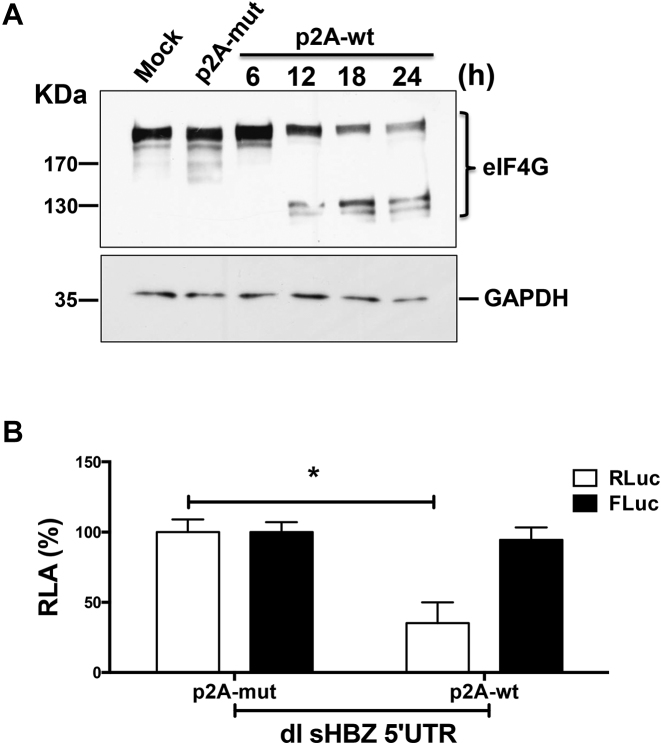
Translation promoted by the sHBZ 5′UTR is resistant to the proteolytic cleavage of eIF4G by the HRV 2A protease. (A) COS-7 cells were transfected with plasmids expressing the wt (p2A-wt) or mutant (p2A-mut) HRV 2A protease. Total protein was harvested from cells transfected with p2A-wt at 6, 12, 18 and 24 h post-transfection. Protein lysates from cells transfected with the empty vector (Mock) or with the p2A-mut plasmid were harvested 24 h post-transfection. Western analysis was performed using a polyclonal antibody against eIF4GI. The positions of the molecular mass standards (in kDa) are shown. (B) COS-7 cells were transfected with plasmids p2A-wt or p2A-mut together with the dl HBZ 5′UTR plasmid and 24 h post-transfection. RLuc and FLuc activities were measured from cell lysates and expressed as RLA (%) to the activities obtained from the lysates expressing p2A-mut, which was set to 100% (+/– SEM). Values represent the mean (+/− SEM) for three independent experiments each conducted in duplicate. Statistical analysis was performed by an ANOVA test followed by a Dunnett’s multiple test comparison (*P < 0.05).